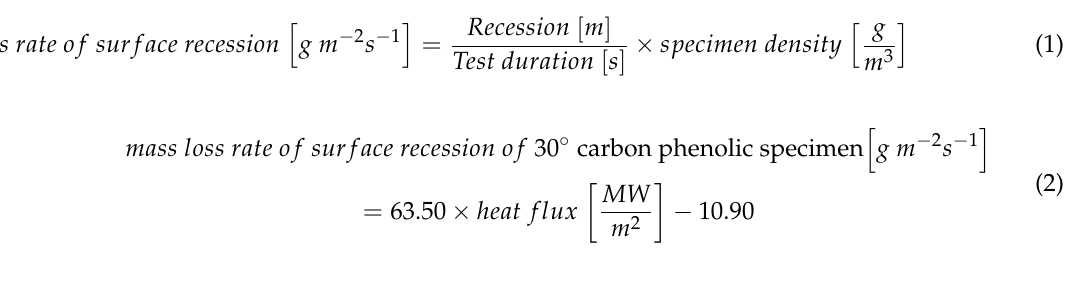
Table 2. Specimen mass loss rate and recession rate.